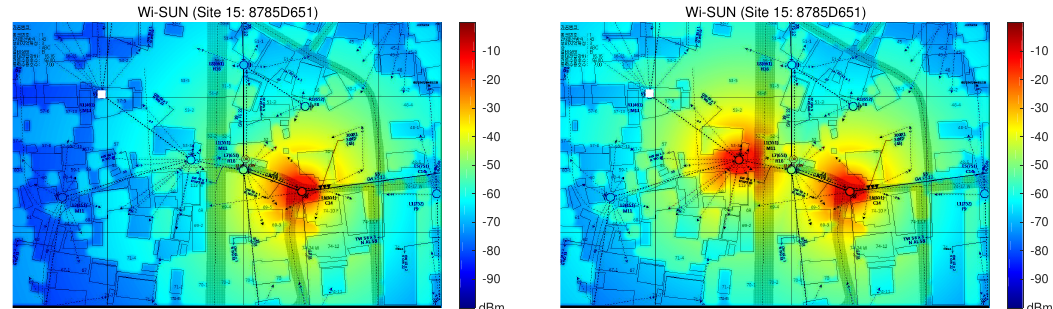
Figure 33. Graphical simulation of the received power for the 920 MHz Wi-SUN modems (Site 1-2, Overhead Residential Area). ( a ) Power map with one node, in which data concentration unit (DCU) and wireless modem are attached below the transformer. ( b ) Power map with two nodes, in which the wireless modem of the second node acts as a